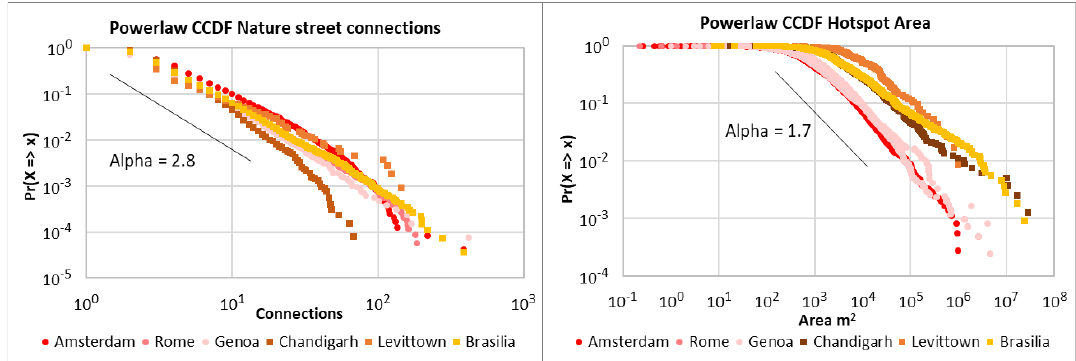
Figure 7. Powerlaw plots of the natural street connections and hotspot areas.